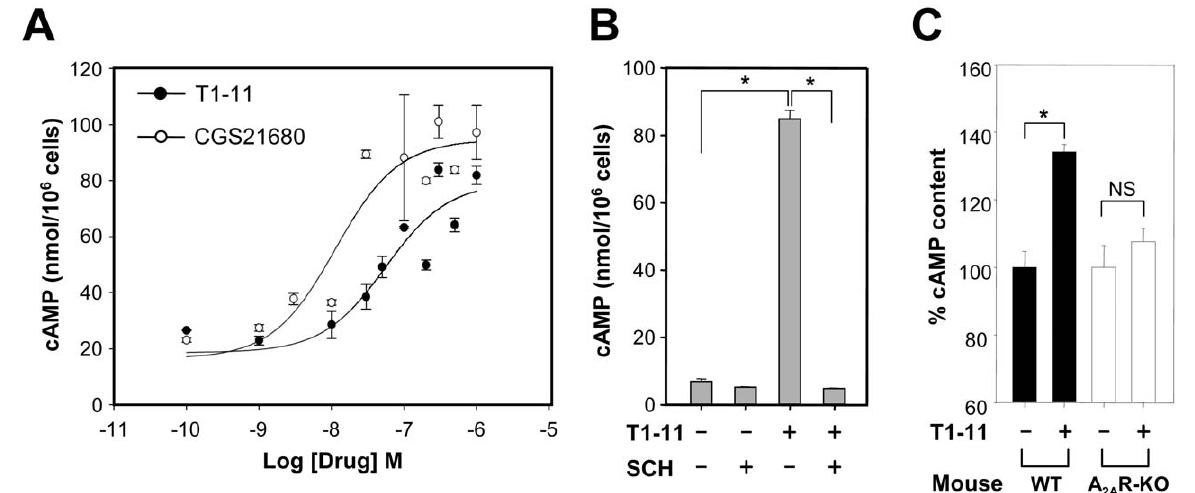
Figure 2. T1-11 is an agonist of the A 2A R. (A) PC12 cells were treated with T1-11 (closed circles) and CGS21680 (open circles) at the indicated concentration for 20 min at room temperature (RT). (B) PC12 cells were stimulated with T1-11 (10 m M) in the absence or presence of an A 2A R antagonist (SCH, 1 m M) for 20 min at RT. (C) Wildtype and A 2A R knockout (KO) mice were intraperitoneally administrated with T1-11 (5 mg/kg body weight, n =4) or vehicle for 60 min to measure the cAMP level in the brain.